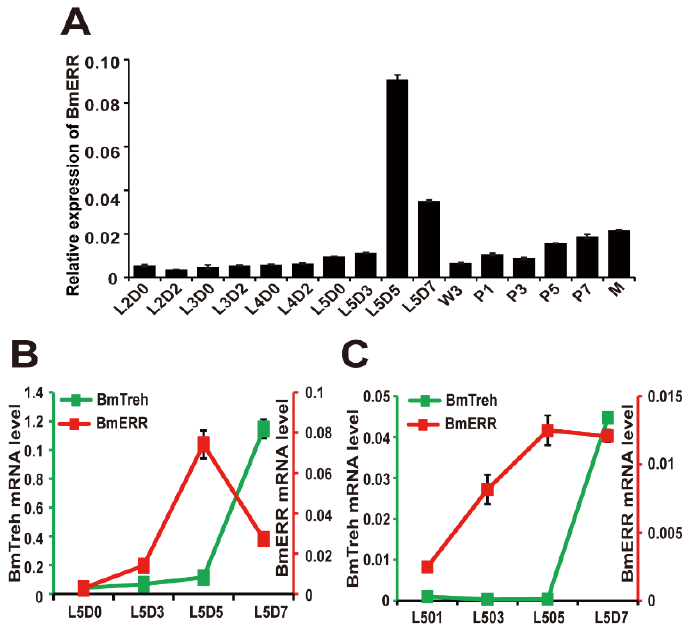
Figure 1. The expression profile of BmERR and BmTreh at different development stages of B. mori . ( A ) The expression profile of BmERR at different development stages; ( B ) The expression profile of BmERR and BmTreh in the midgut of the last instar B. mori ; ( C ) The expression profile of BmERR and BmTreh in the silk gland of the last instar B. mori . L2/3/4/5D0 indicates the first/second/third/fourth instar molting larvae; L2/3/4/D2 indicates the second day of the second/third/fourth instar larvae; L5D/3/5/7 indicates the third/fifth/seventh day of fifth instar larvae; W3: day 3 of wandering; P1, P3, P5, and P7: days 1, 3, 5, and 7 of pupation, respectively; M: moths.